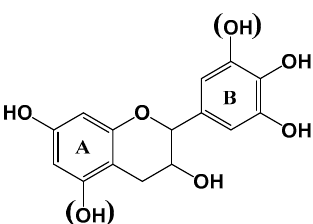
Figure 1. Flavonoid units involved in the formation of oligomers.